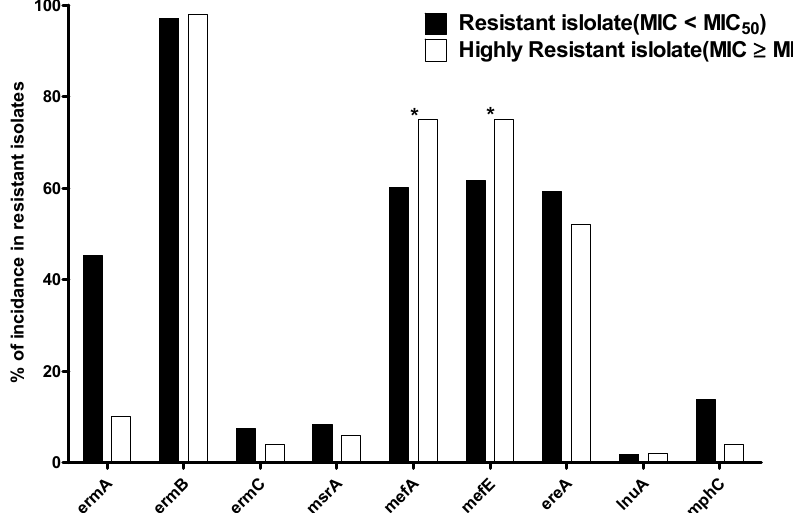
Figure 8. The distribution of MLS genes in the highly resistant isolates that showed MIC ≥ MIC 50 . The efflux encoding genes mefA and mefE were significantly increased in the highly resistant isolates (MIC ≥ MIC 50 ) than in other resistant isolates with MIC < MIC 50 . That could explain the increased role of efflux in resistance to both antibiotics and biocides. * p < 0.05.